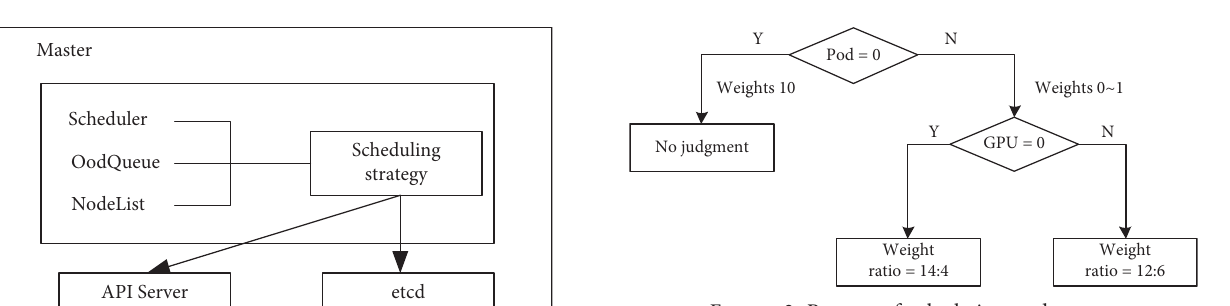
Figure 2: Process of calculating node